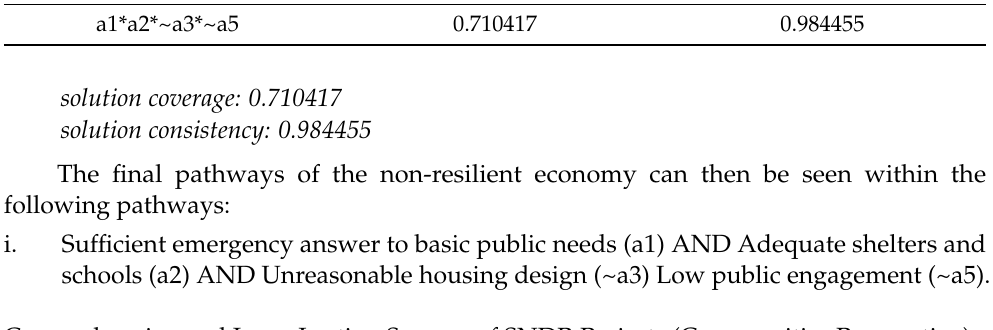
Table A14. Failure pathways (outcome A3)- The mark * resembles “and.”. Solutions